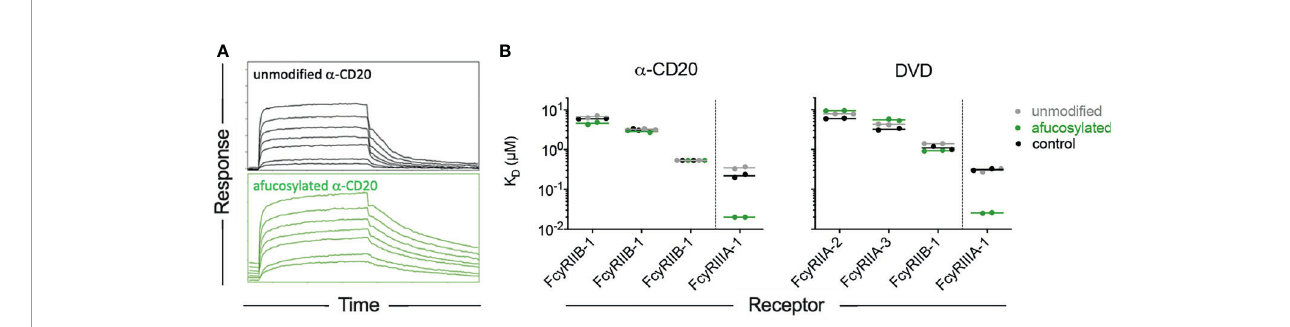
FIGURE 5 | The fucose effect is generalizable across antibodies but not receptors. (A) Representative sensorgrams showing association and dissociation pro fi les of RM FcgRIIIa-3 from unmodi fi ed and afucosylated forms of a rhesusized version of rituximab. (B) Equilibrium binding af fi nities of CDR grafted CD20-speci fi c antibodies with rhesus IgG1 Fc domains (left), and a dual variable domain (DVD) bispeci fi c antibody (right) in unmodi fi ed and afucosylated forms, and in comparison to an unmodi fi ed rhesus IgG1 antibody of a differing speci fi